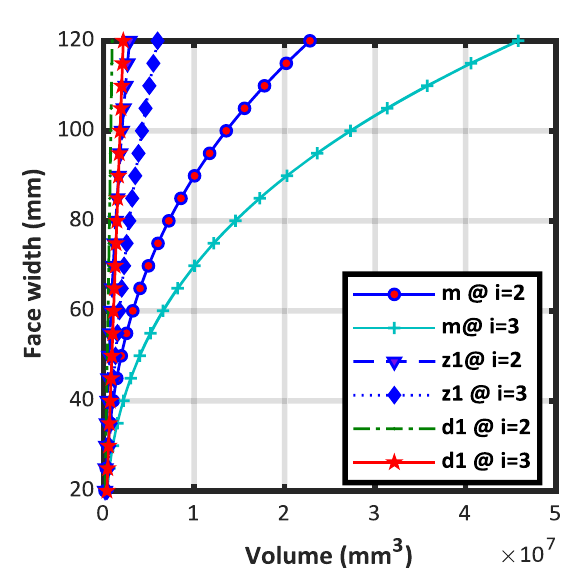
Fig. 12. Volume/face-width variation.